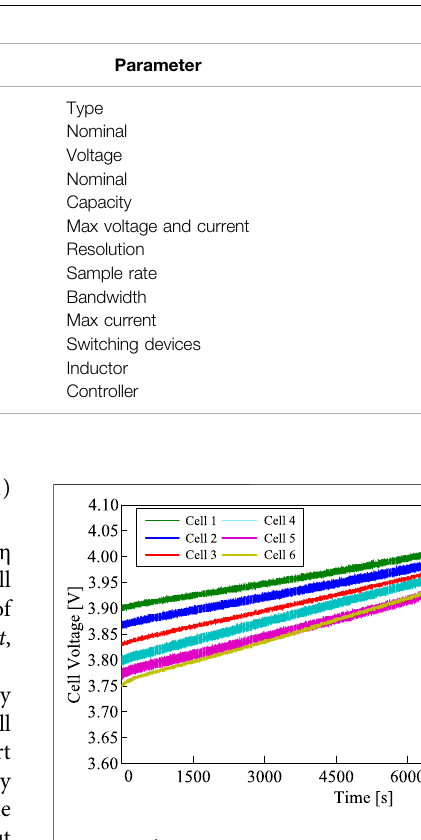
FIGURE 4 | Terminal voltages of six cells during the charging process with a static acceleration coef fi cient.